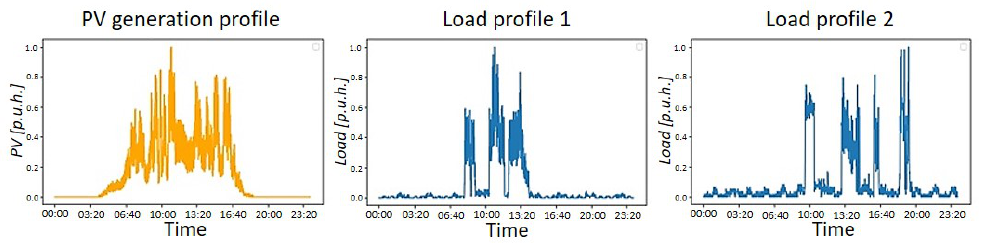
Figure A1. ( Left ): PV profile; ( Center ): Load profile 1; ( Right ): Load profile 2.